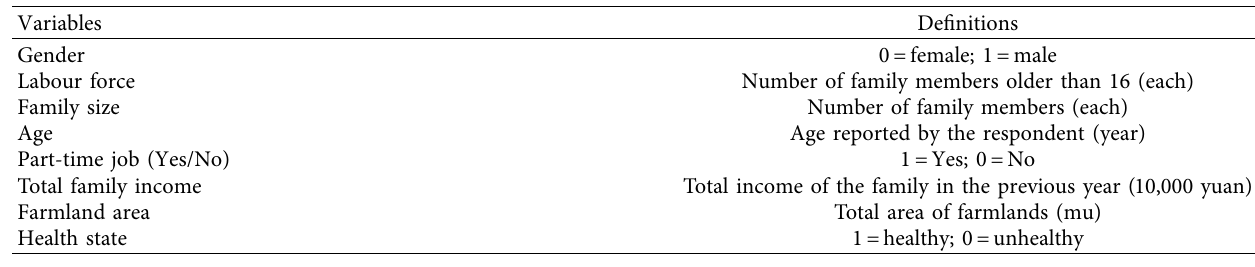
Table 9: Social economic variables and their definitions in the MNL model.